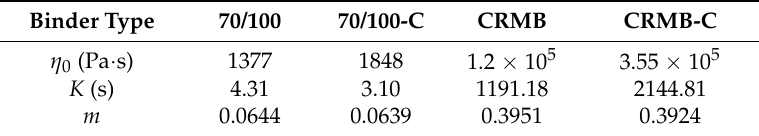
Table 4. Zero shear viscosity (ZSV) fitting results using the Cross